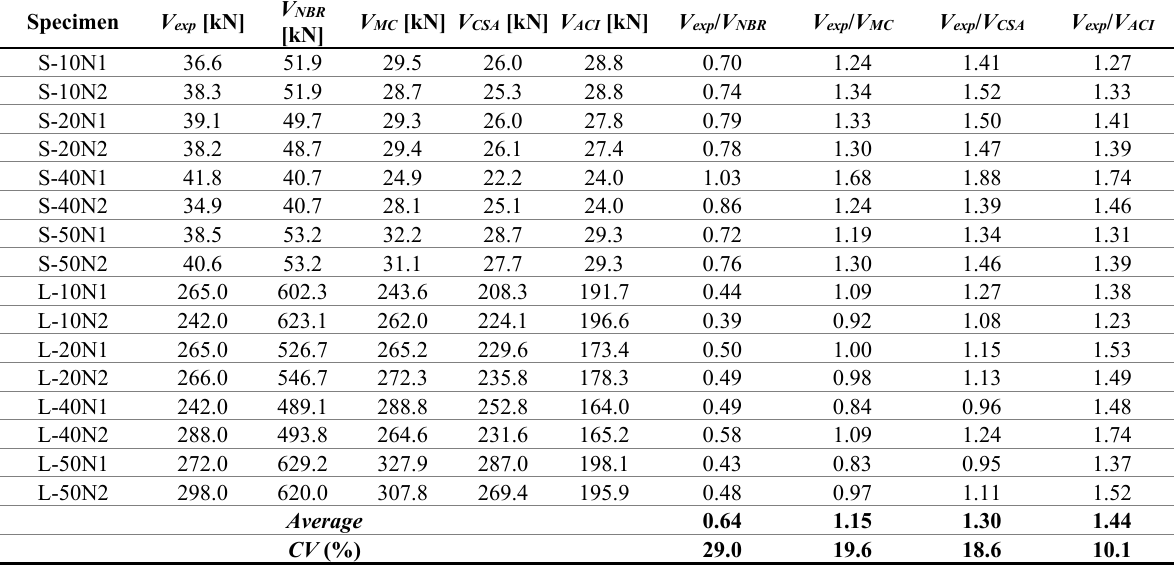
Table 7. Comparison of analytical shear strength force with experimental